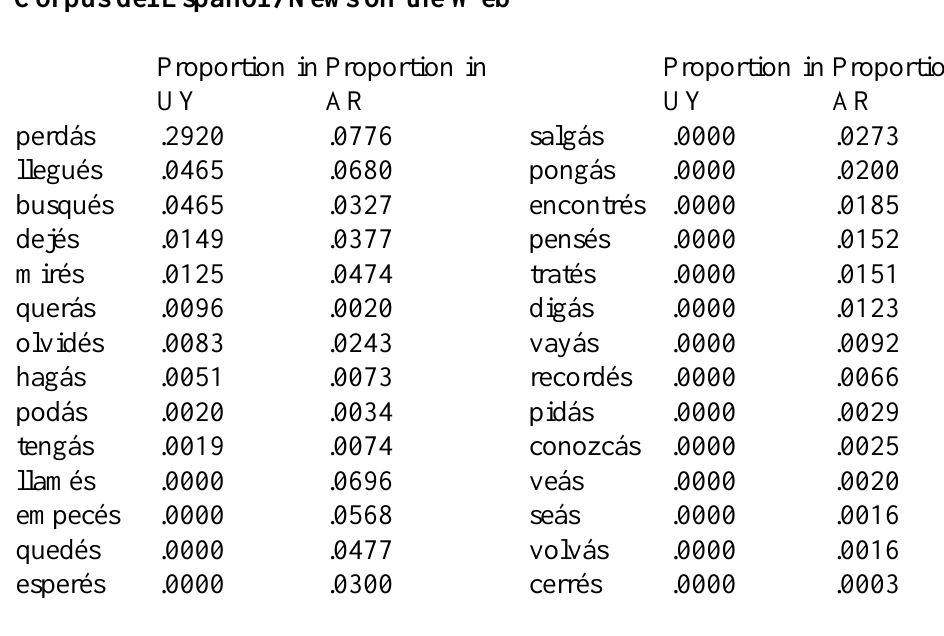
Table 4. Non-standard present subjunctive forms with final stress. Data from Corpus del Español / News on the